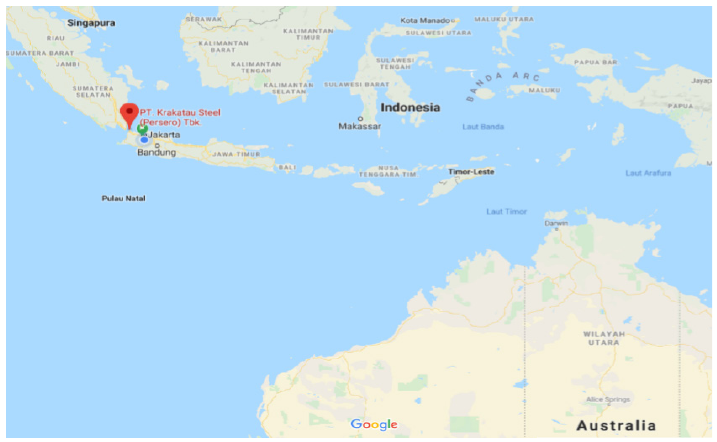
Figure 2: Coal supply flow used by Krakatau